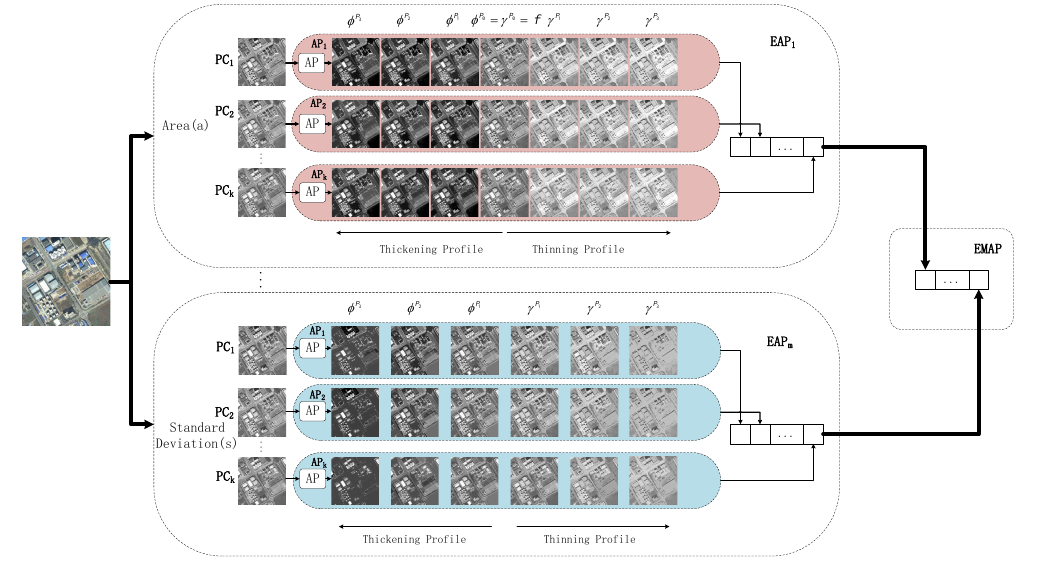
Figure 2. General architecture of